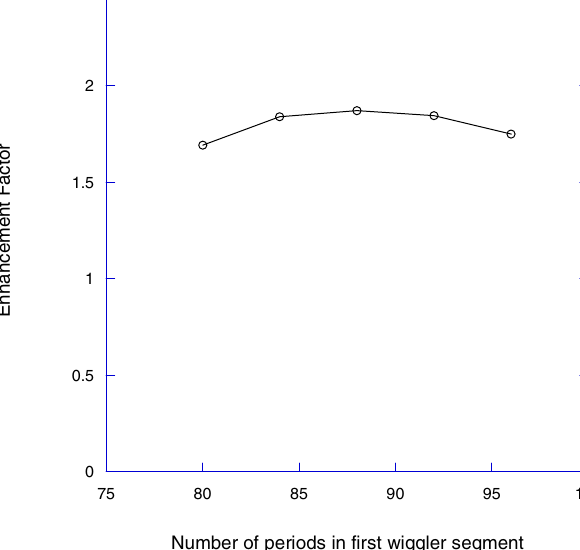
FIG. 11. (Color) Efficiency enhancement of the two-stage wig- gler versus the number of periods in the first wiggler segment.